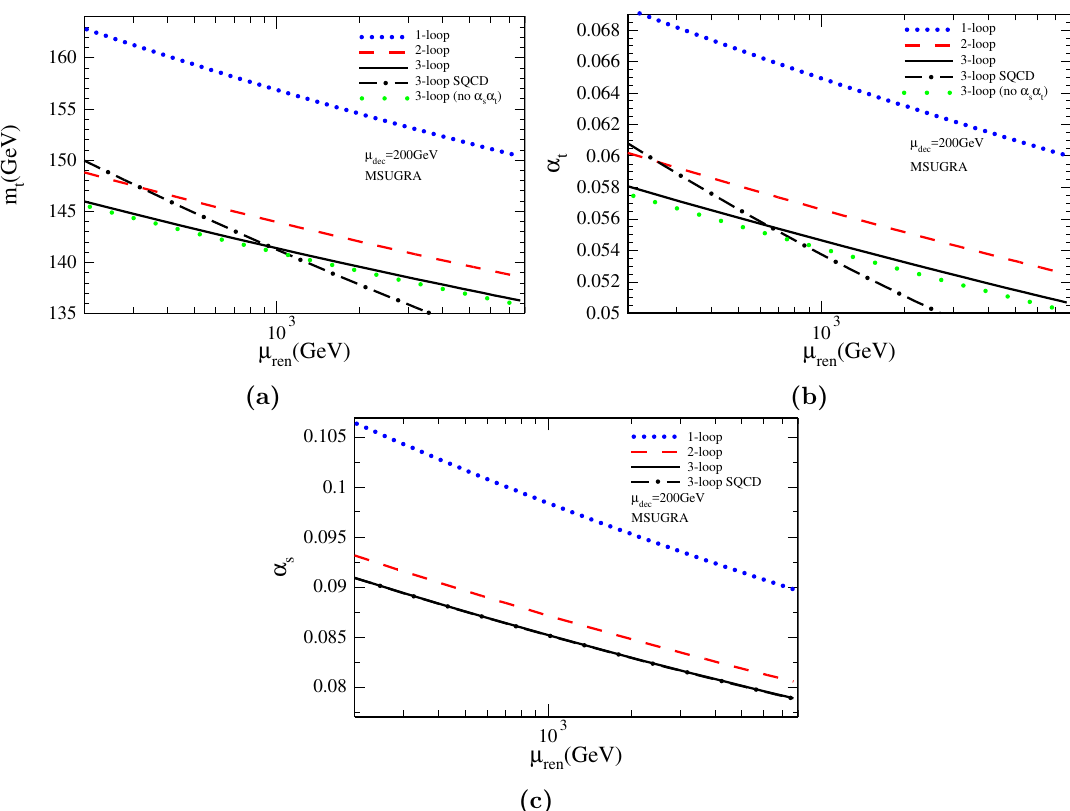
Figure 4. Renormalization scale dependence for m t , (cid:11) t , and (cid:11) s for (cid:22) dec = 200 GeV. The dotted, dashed and full lines correspond to one-, two- and three-loop running. The dot-dashed lines display the three-loop SUSY-QCD contributions. The large dotted lines marked in the legend with the label (no (cid:11) s (cid:11) t ) show the predictions of the three-loop analysis, where the O ( (cid:11) s (cid:11) t ) contributions to the decoupling coe(cid:14)cients for m t and (cid:11) t were excluded. comparing the full and dot-dashed lines in the (cid:12)gure, the genuine SUSY-QCD contributions are su(cid:14)cient for the prediction of the energy evolution of (cid:11) . However, the running of m s